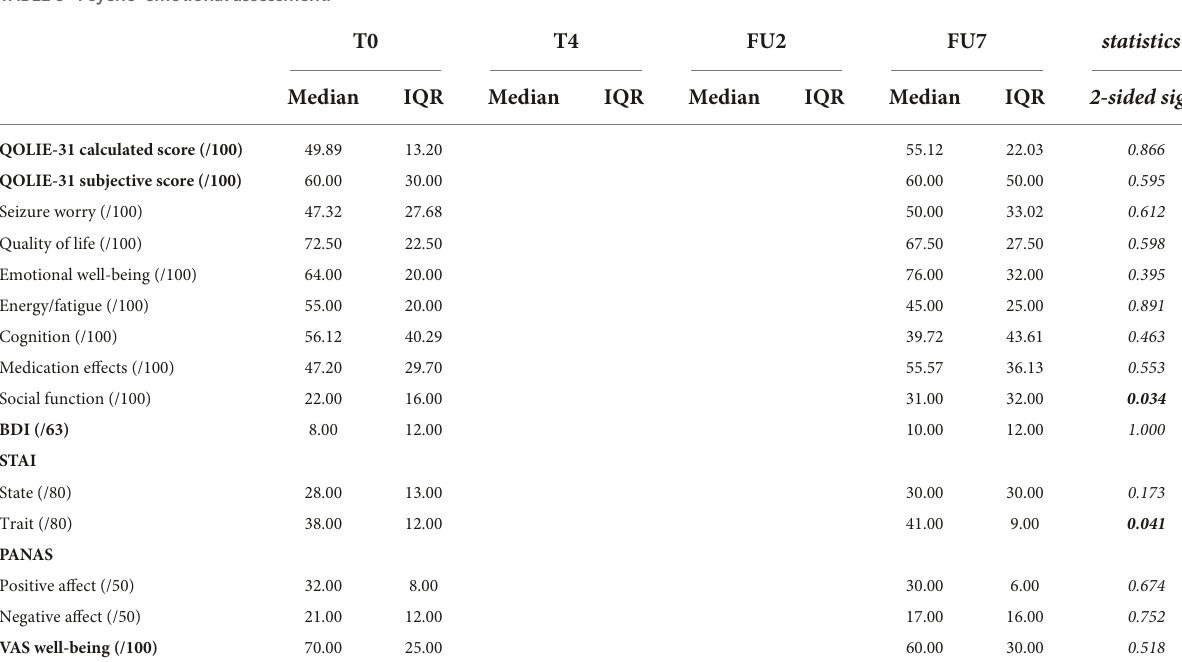
TABLE 5 Psycho-emotional assessment.